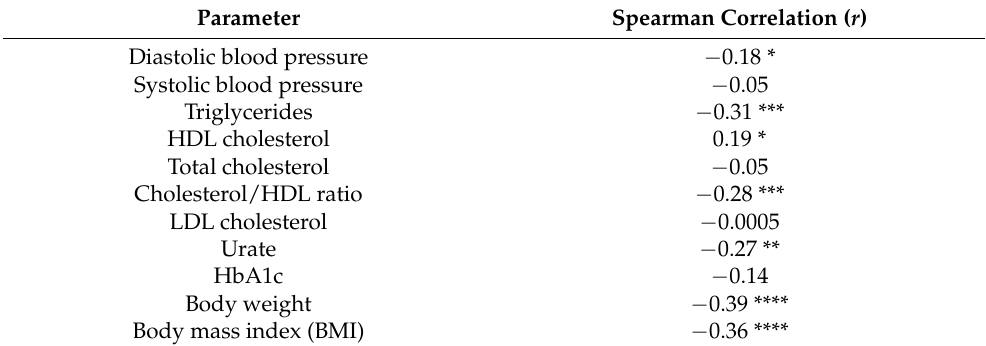
Table 4. Correlations of plasma vitamin C status with cardiometabolic health parameters ( n = 136).